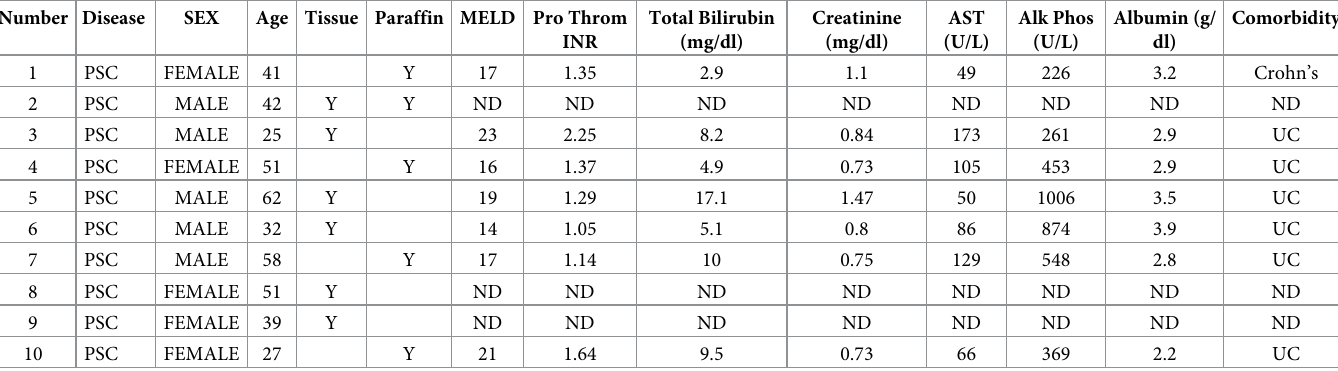
Table 1. Serum biochemical parameters of human PSC patients. Number